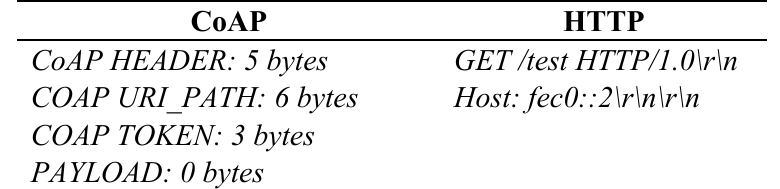
Table 2. Composition of the HTTP and CoAP Confirmable (CON) requests. In both cases the requests are sent using the GET